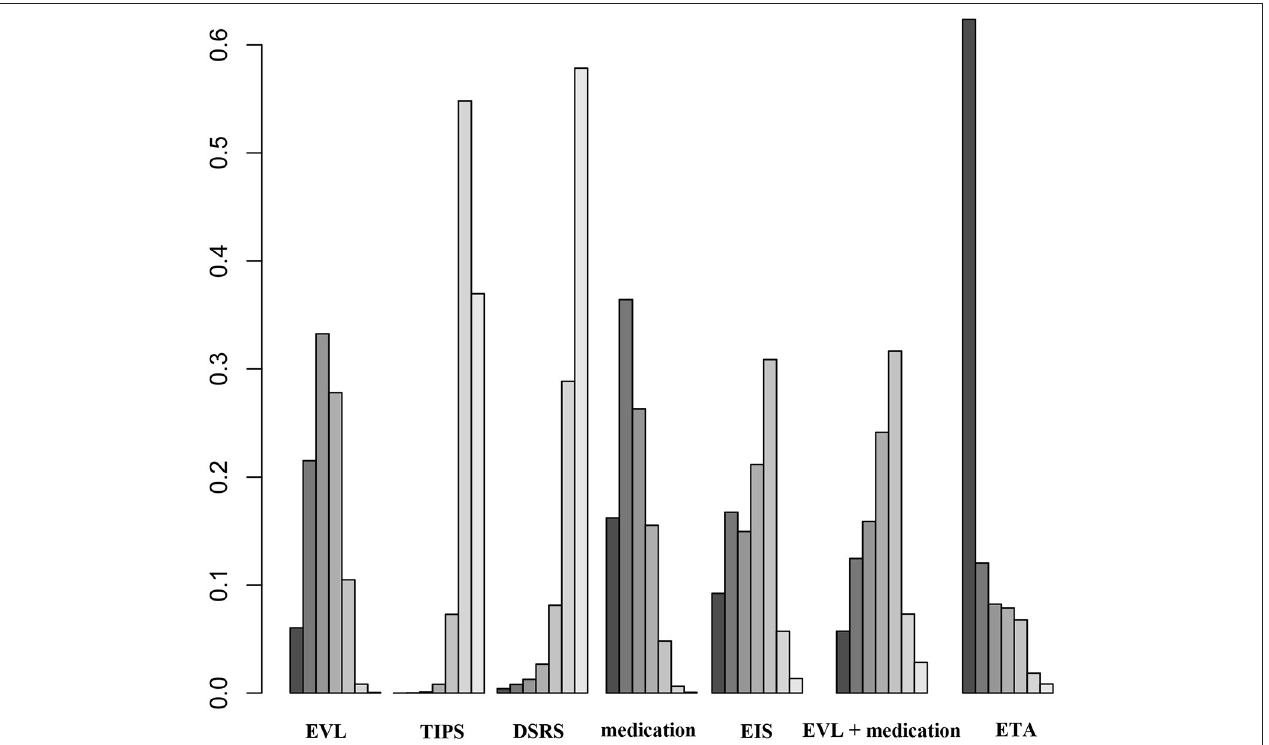
FIGURE 7 | Ranking of the odds ratios for HE based on different pairwise comparisons. EVL, endoscopic variceal ligation; TIPS, transjugular intrahepatic portosystemic shunt; DSRS, distal splenorenal shunt; EIS, endoscopic injection sclerotherapy; ETA, endoscopic tissue.